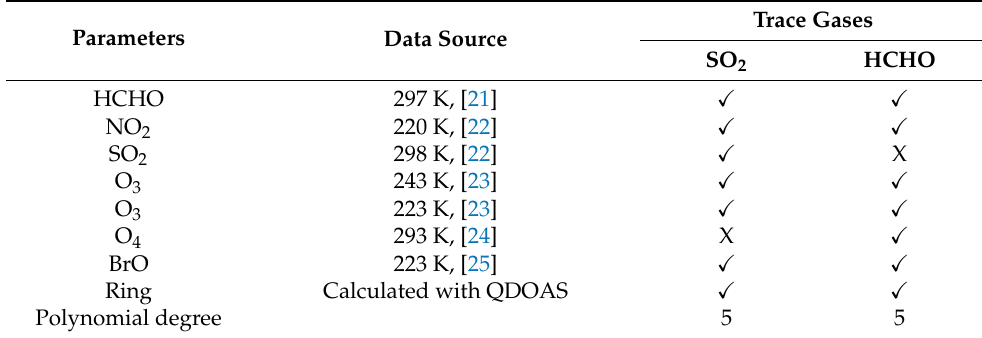
Table 1. Retrieval Settings for the spectral analysis of HCHO and SO 2 using